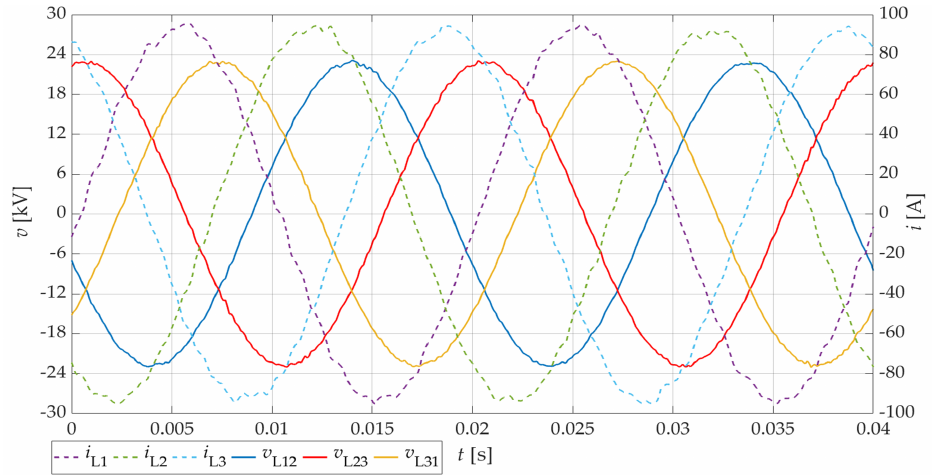
Figure 25. Waveforms of instantaneous values of line voltages and currents of a block transformer of a generating unit for normal operation (steady state, the generating unit worked with the rated power).